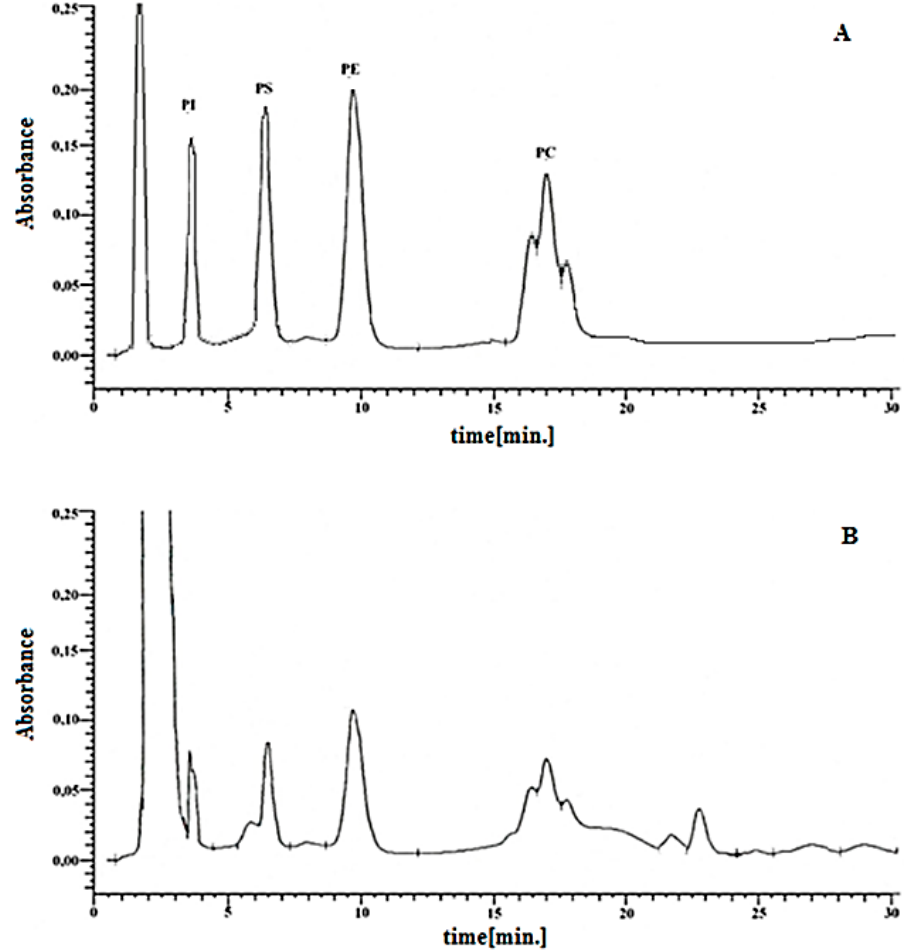
Figure 1. Chromatogram of the phospholipid standard mixture ( A ) and total keratinocyte lipid extract ( B ) PI-phosphatidylinositol, PS-phosphatidylserine, PE-phosphatidylethanolamine, PC-phosphatidylcholine.